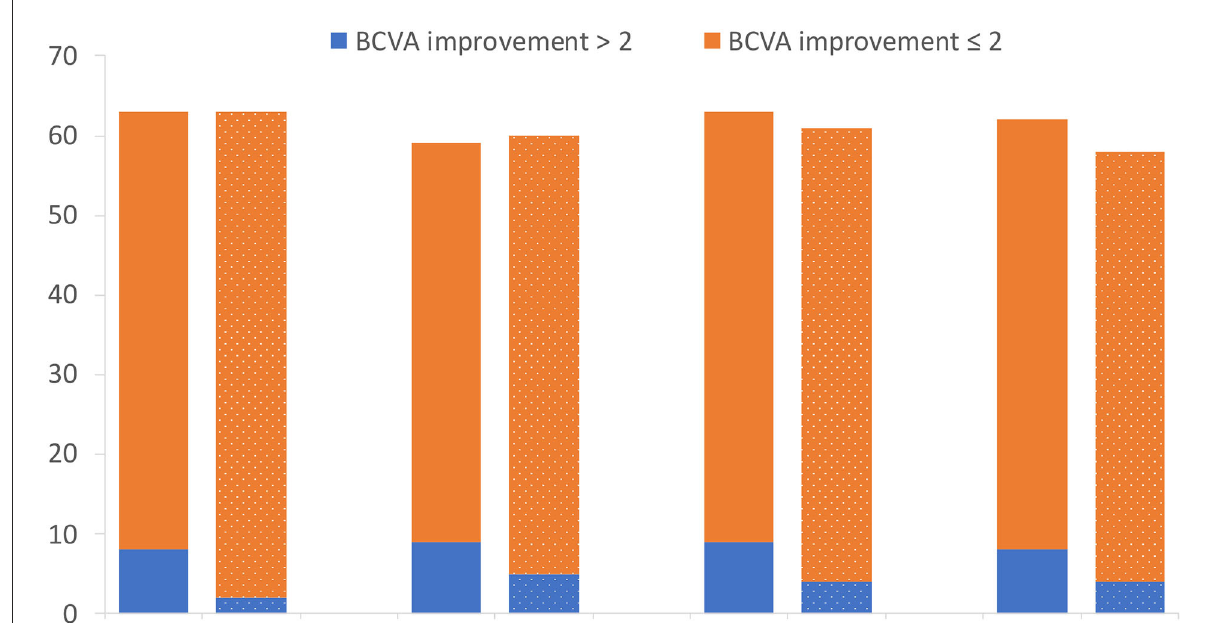
FIGURE4 The number of patients with different categories of best-corrected visual acuity (BCVA) improvement in the two groups. The number of patients with different categories of BCVA improvement in logMAR (Logarithm of the Minimum Angle of Resolution) scale at week 1, month 1, month 2, and month 3 after surgery comparing to baseline in the preoperative intravitreal aflibercept (IVA) injection group and control group (bar with dotted pattern).